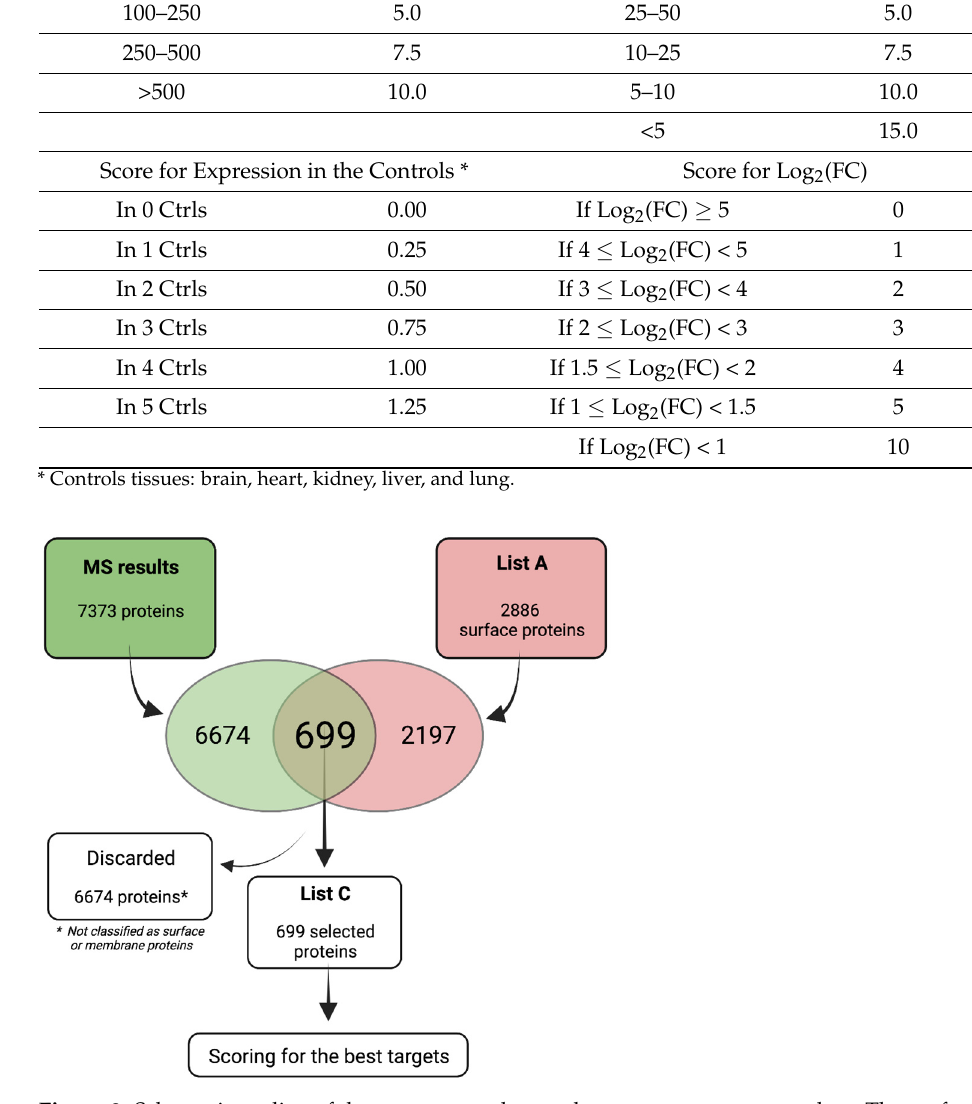
Figure 3. Schematic outline of the strategy used to analyze mass spectrometry data. The surfaceome of six FP-RMS cell lines, five FN-RMS cell lines, and three RMS PDXs were analyzed by MS. The strategy adopted to analyze the MS data is shown. The MS results were filtered with a list of annotated surface proteins (List A). A total of 699 proteins predicted to be surface proteins (List C) were then further prioritized by a scoring strategy to identify highly expressed proteins specific to RMS.